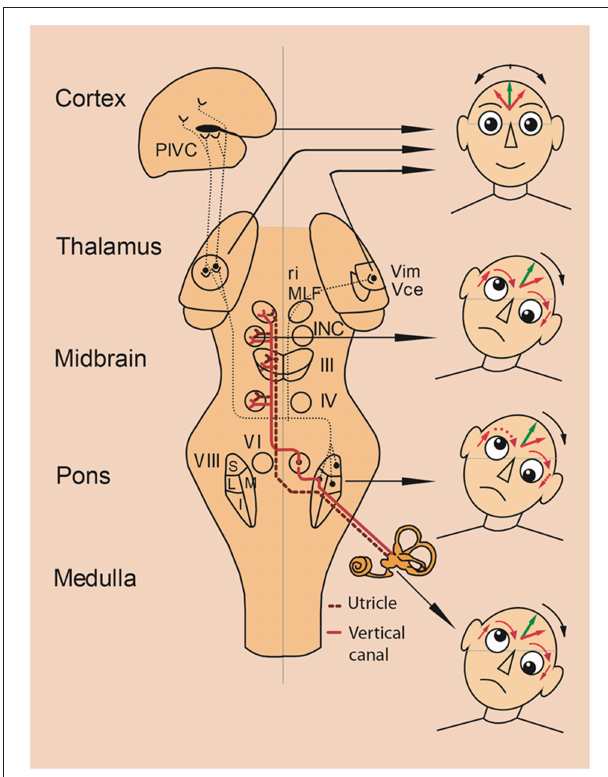
FIGURE 3 | Vestibular lesions manifesting with SVV tilts and ocular tilt reaction. Pathways from the utricles and vertical semicircular canals mediate graviceptive function in the frontal roll plane. These pathways ascend from the vestibular nuclei (VIII) to the ocular motor nuclei, including the trochlear nucleus (IV), oculomotor nucleus (III) and abducens nucleus (VI). From here, they travel to the supranuclear centers of the interstitial nucleus of Cajal (INC), and the rostral interstitial nucleus of the MLF (riMLF) in the midbrain tegmentum. This circuitry is the basis for the vestibulo-ocular reflex, and is connected with vestibulospinal reflexes to control eye, head, and body posture. Projections via the thalamus (Vim, Vce) to the parieto-insular vestibular cortex (PIVC) subserve perception of verticality. Unilateral lesions of the graviceptive vestibular pathways cause vestibular tone imbalance in the roll plane. Patients with such lesions can present with an ocular tilt reaction—an eye—head synkinesis with vertical divergence of the eyes (skew deviation), ocular torsion, head tilt, and tilt of the subjective visual vertical. Right-hand images depict the resulting vestibular syndromes according to the level of the unilateral graviceptive pathway lesion. These pathways cross at the pontine level, so the direction of tilt is ipsiversive with peripheral or pontomedullary lesions (bottom two heads) and contraversive with pontomesencephalic lesions above the crossing (head at midbrain level). In thalamic and vestibular cortex lesions, there are no eye and head tilts, and tilts of the subjective visual vertical are contraversive or ipsiversive (top head). Head images: green arrows in the forehead represent objective visual vertical; red arrows represent pathological subjective visual vertical; and red arrows around the eyes represent pathological vertical deviation and torsion of the eyes. I, inferior; L, lateral; M, medial; S, superior subnuclei of the vestibular nucleus (VIII). [Modified from Brandt and Dieterich (23)].